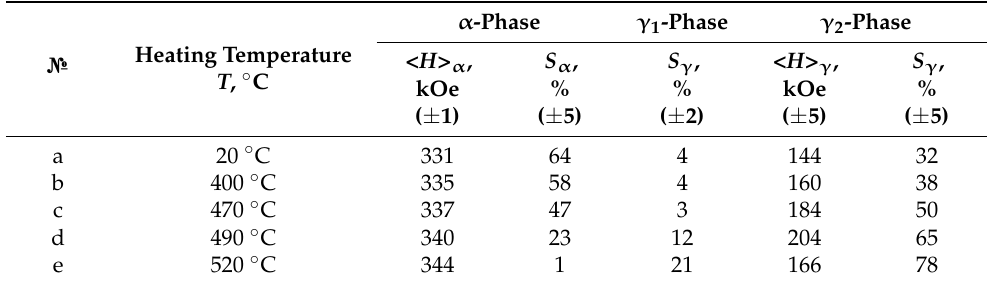
Table 1. Mean hyperfine magnetic field values < H > and integral intensities S of Mössbauer spectra components α , γ 1 and γ 2 (shown in Figure 1a–e) of the FeNi 31.1 alloy after the slow heating